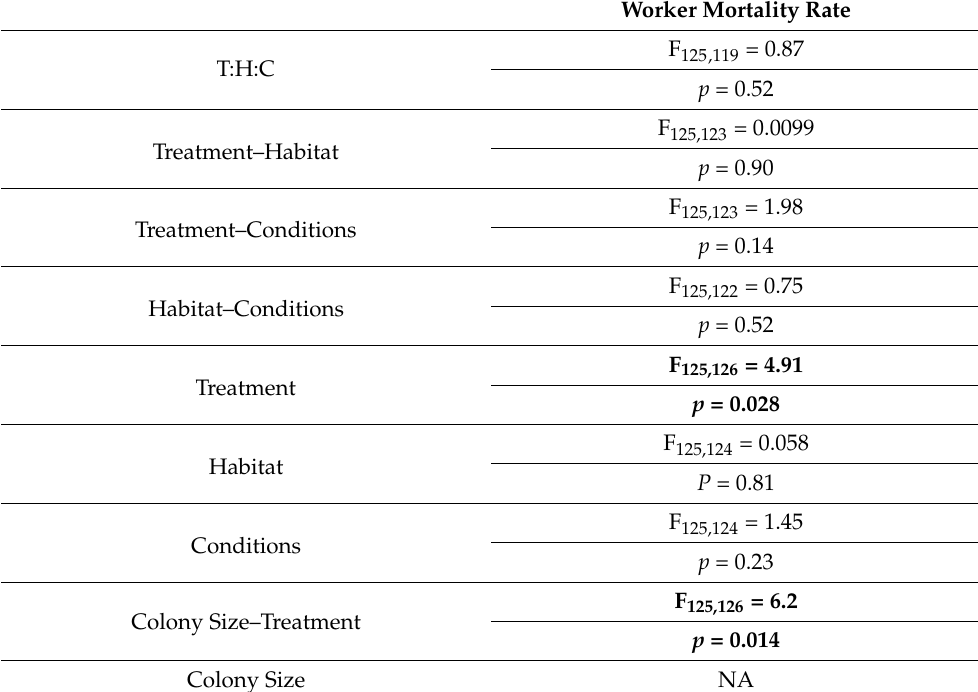
Table 1. Summary of the statistical analyses on workers testing the effects of hibernation conditions (lab and field), type of habitat (city and forest), and treatment (control or cadmium) on the workers mortality rate. T:H:C means treatment–habitat–conditions triple interaction. Bold number indicates significant p